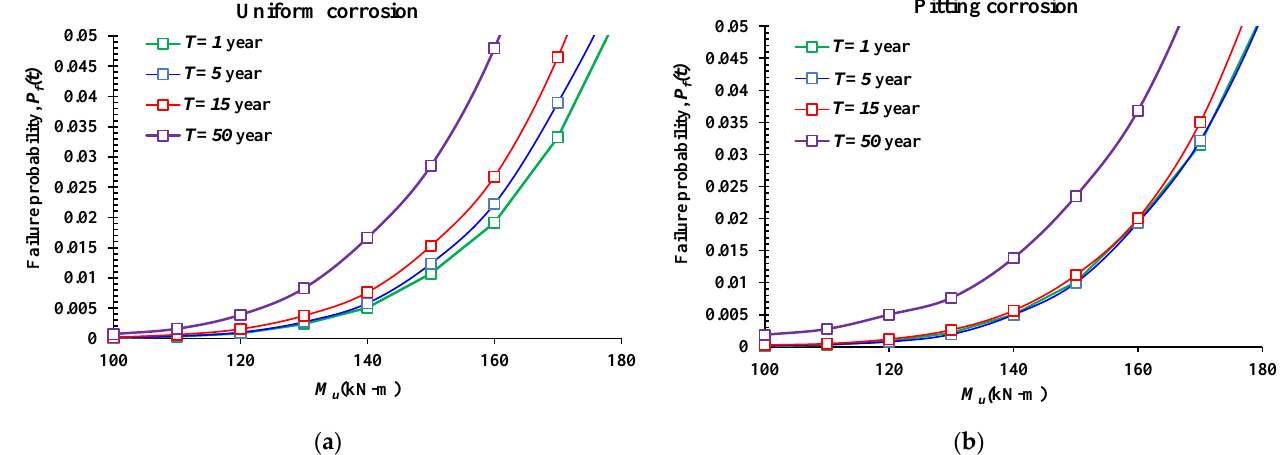
Figure 8. Influence of the external load ( M u ) on the reliability results. ( a ) Uniform corrosion form, ( b ) pitting corrosion form.